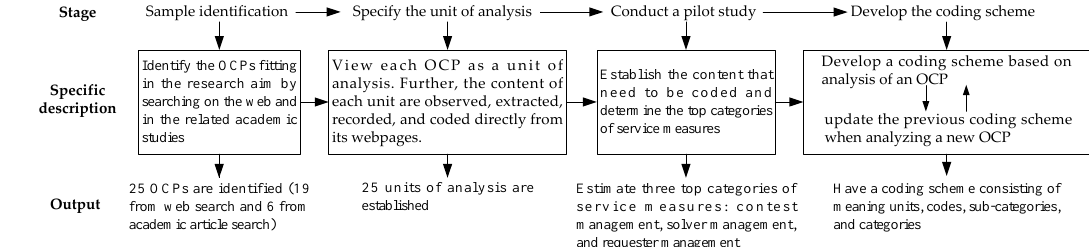
Figure 1. The application procedure of content analysis.